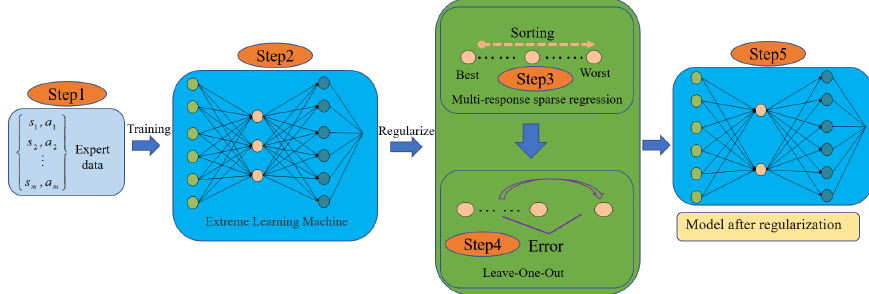
Figure 4. Algorithm structure of rgw regularized extreme learning